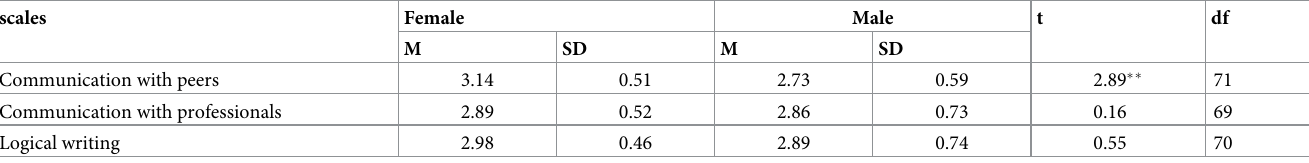
Table 2. Descriptive statistics and t -test results for language challenges (female vs. male). scales